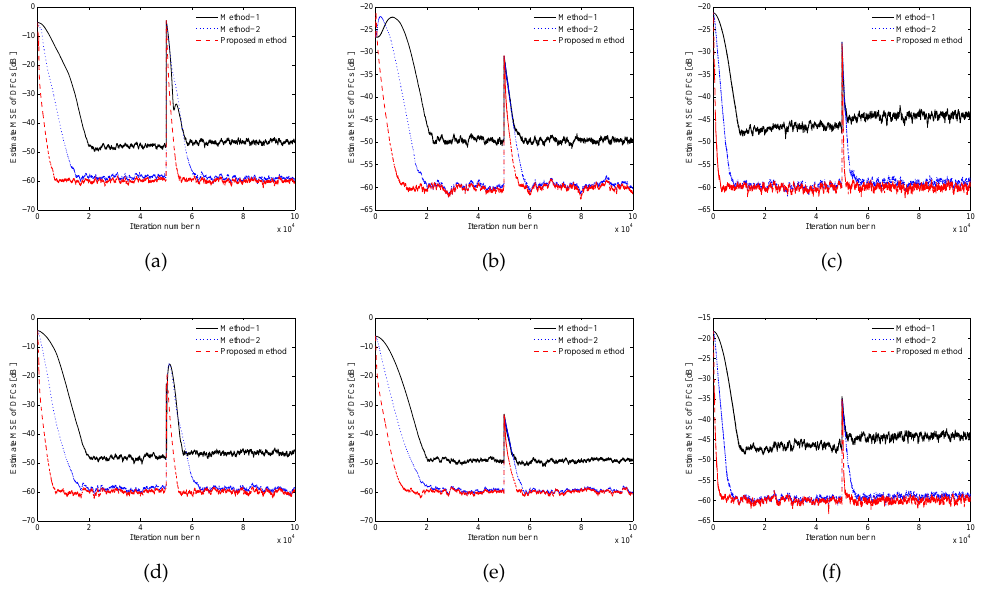
Figure 9. Comparison between the DFC estimation MSEs of Method 1, Method 2, and the proposed method for the variable acoustic path S ( z ) shown in Figure 4. ( a ) E [ ε 2 a ( n )] ; ( e ) E [ ε 2 ( n )] ; (f) E [ ε 2 ( n )] ( d ) E [ ε 2 b 1 b 2 b 3